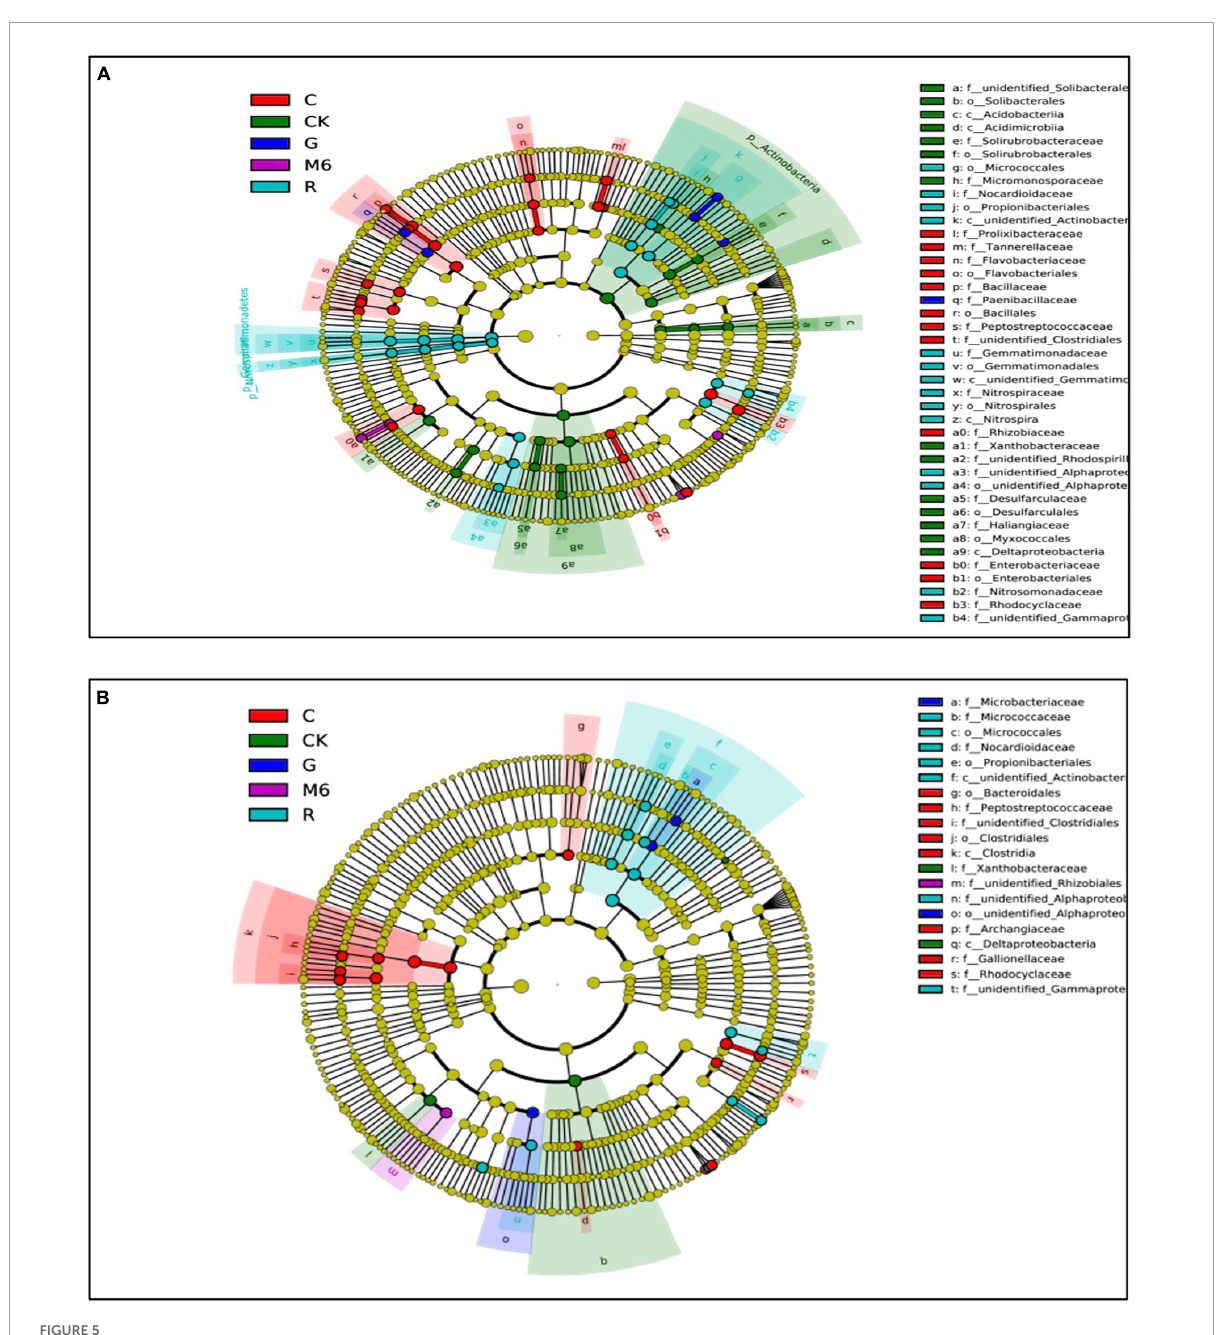
FIGURE5 LEfSe cladogram indicating the phylogenetic distribution of bacteria lineages under different treatments in HC (A) and LC (B) soils. In the figure, red, green, dark blue, purple, and light blue circles, respectively represent the flora of C, CK, G, M6, and R treatments which are significantly higher than those of the other four treatments. LDA > 3 is taken to represent the significant difference, and the circles from inside to outside, respectively represent the classification level of domain, phylum, class, order, family, genus, and species. CK, control; M6, M6 strain; C, M6 + Biochar; G, M6 + Glutamic acid; R, M6 + rhamnolipid; FY, Fuyang County; ZJ, Zhuji County; LC, low cadmium; HC, high cadmium; LEfSe, Linear discriminant analysis effect size; LDA, Linear discriminant